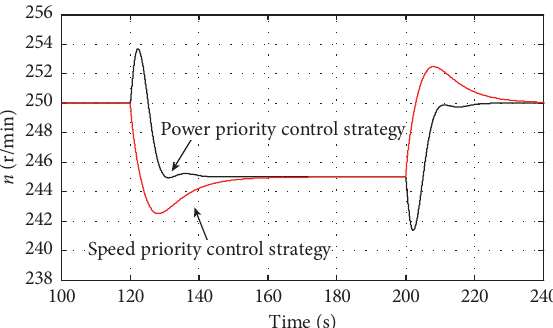
Figure 35: Speed comparison diagram when P